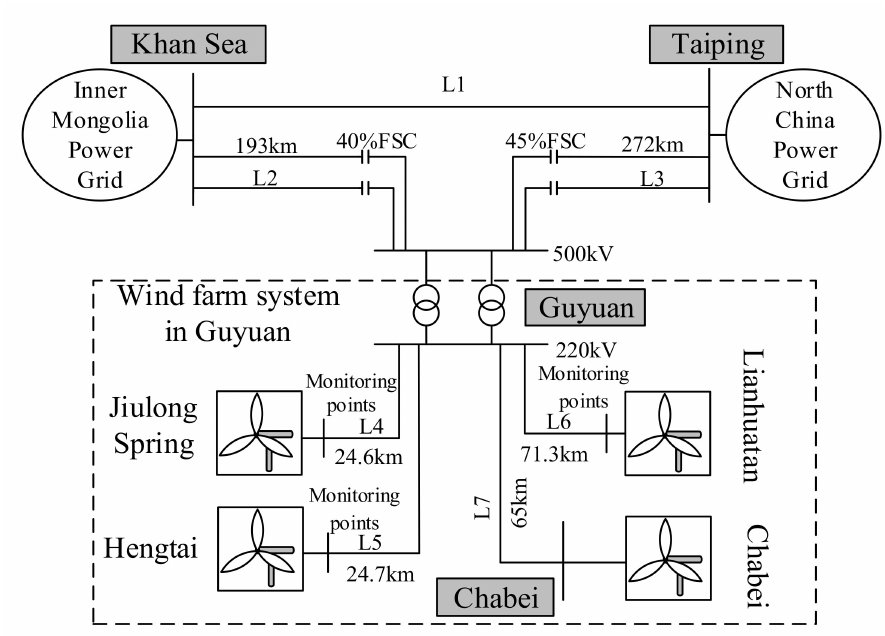
Figure 12. Wind farm system in Guyuan, Hebei.